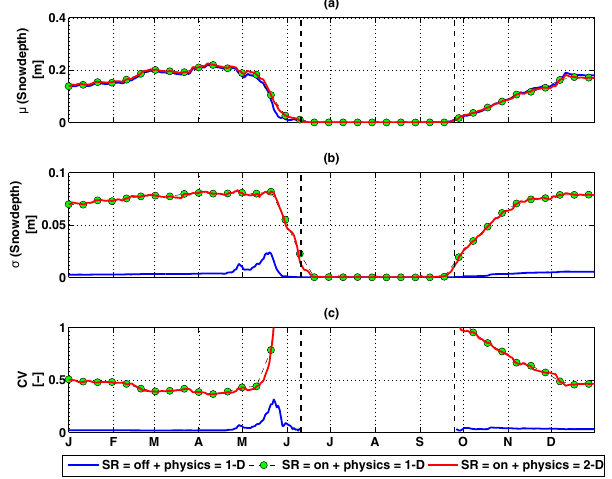
Figure 4. (a) Mean, (b) standard deviation, and (c) coefficient of variation of simulated snow depth across the entire domain for 1-D and 2-D subsurface